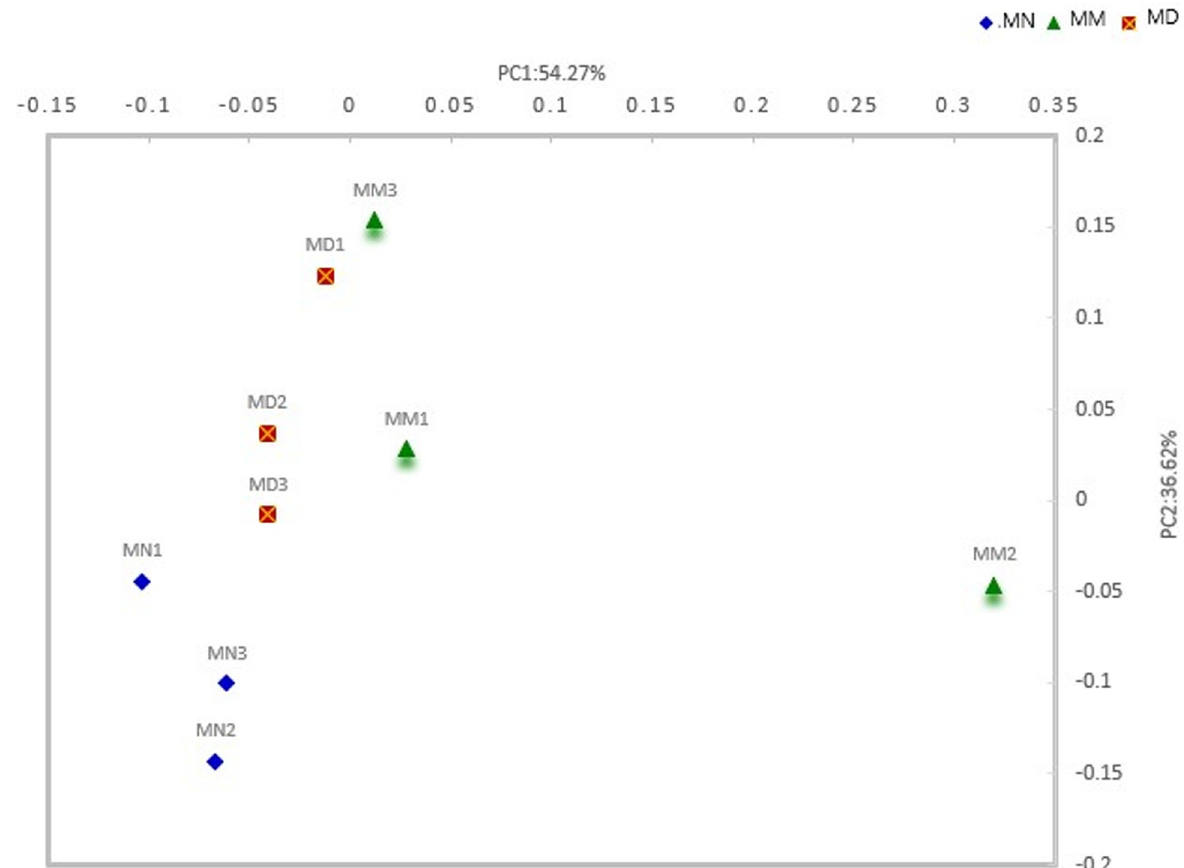
Fig 7. Composition of the microbial community. Sample 2d collation diagram analyzed by Weighted UniFrac PCoA.